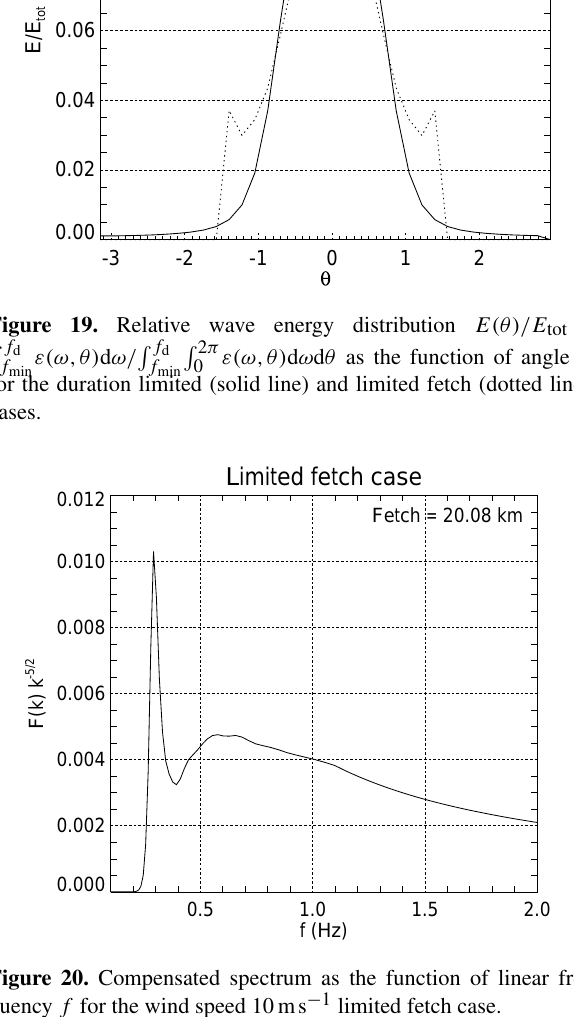
Figure 20. Compensated spectrum as the function of linear fre- quency f for the wind speed 10ms − 1 limited fetch case.